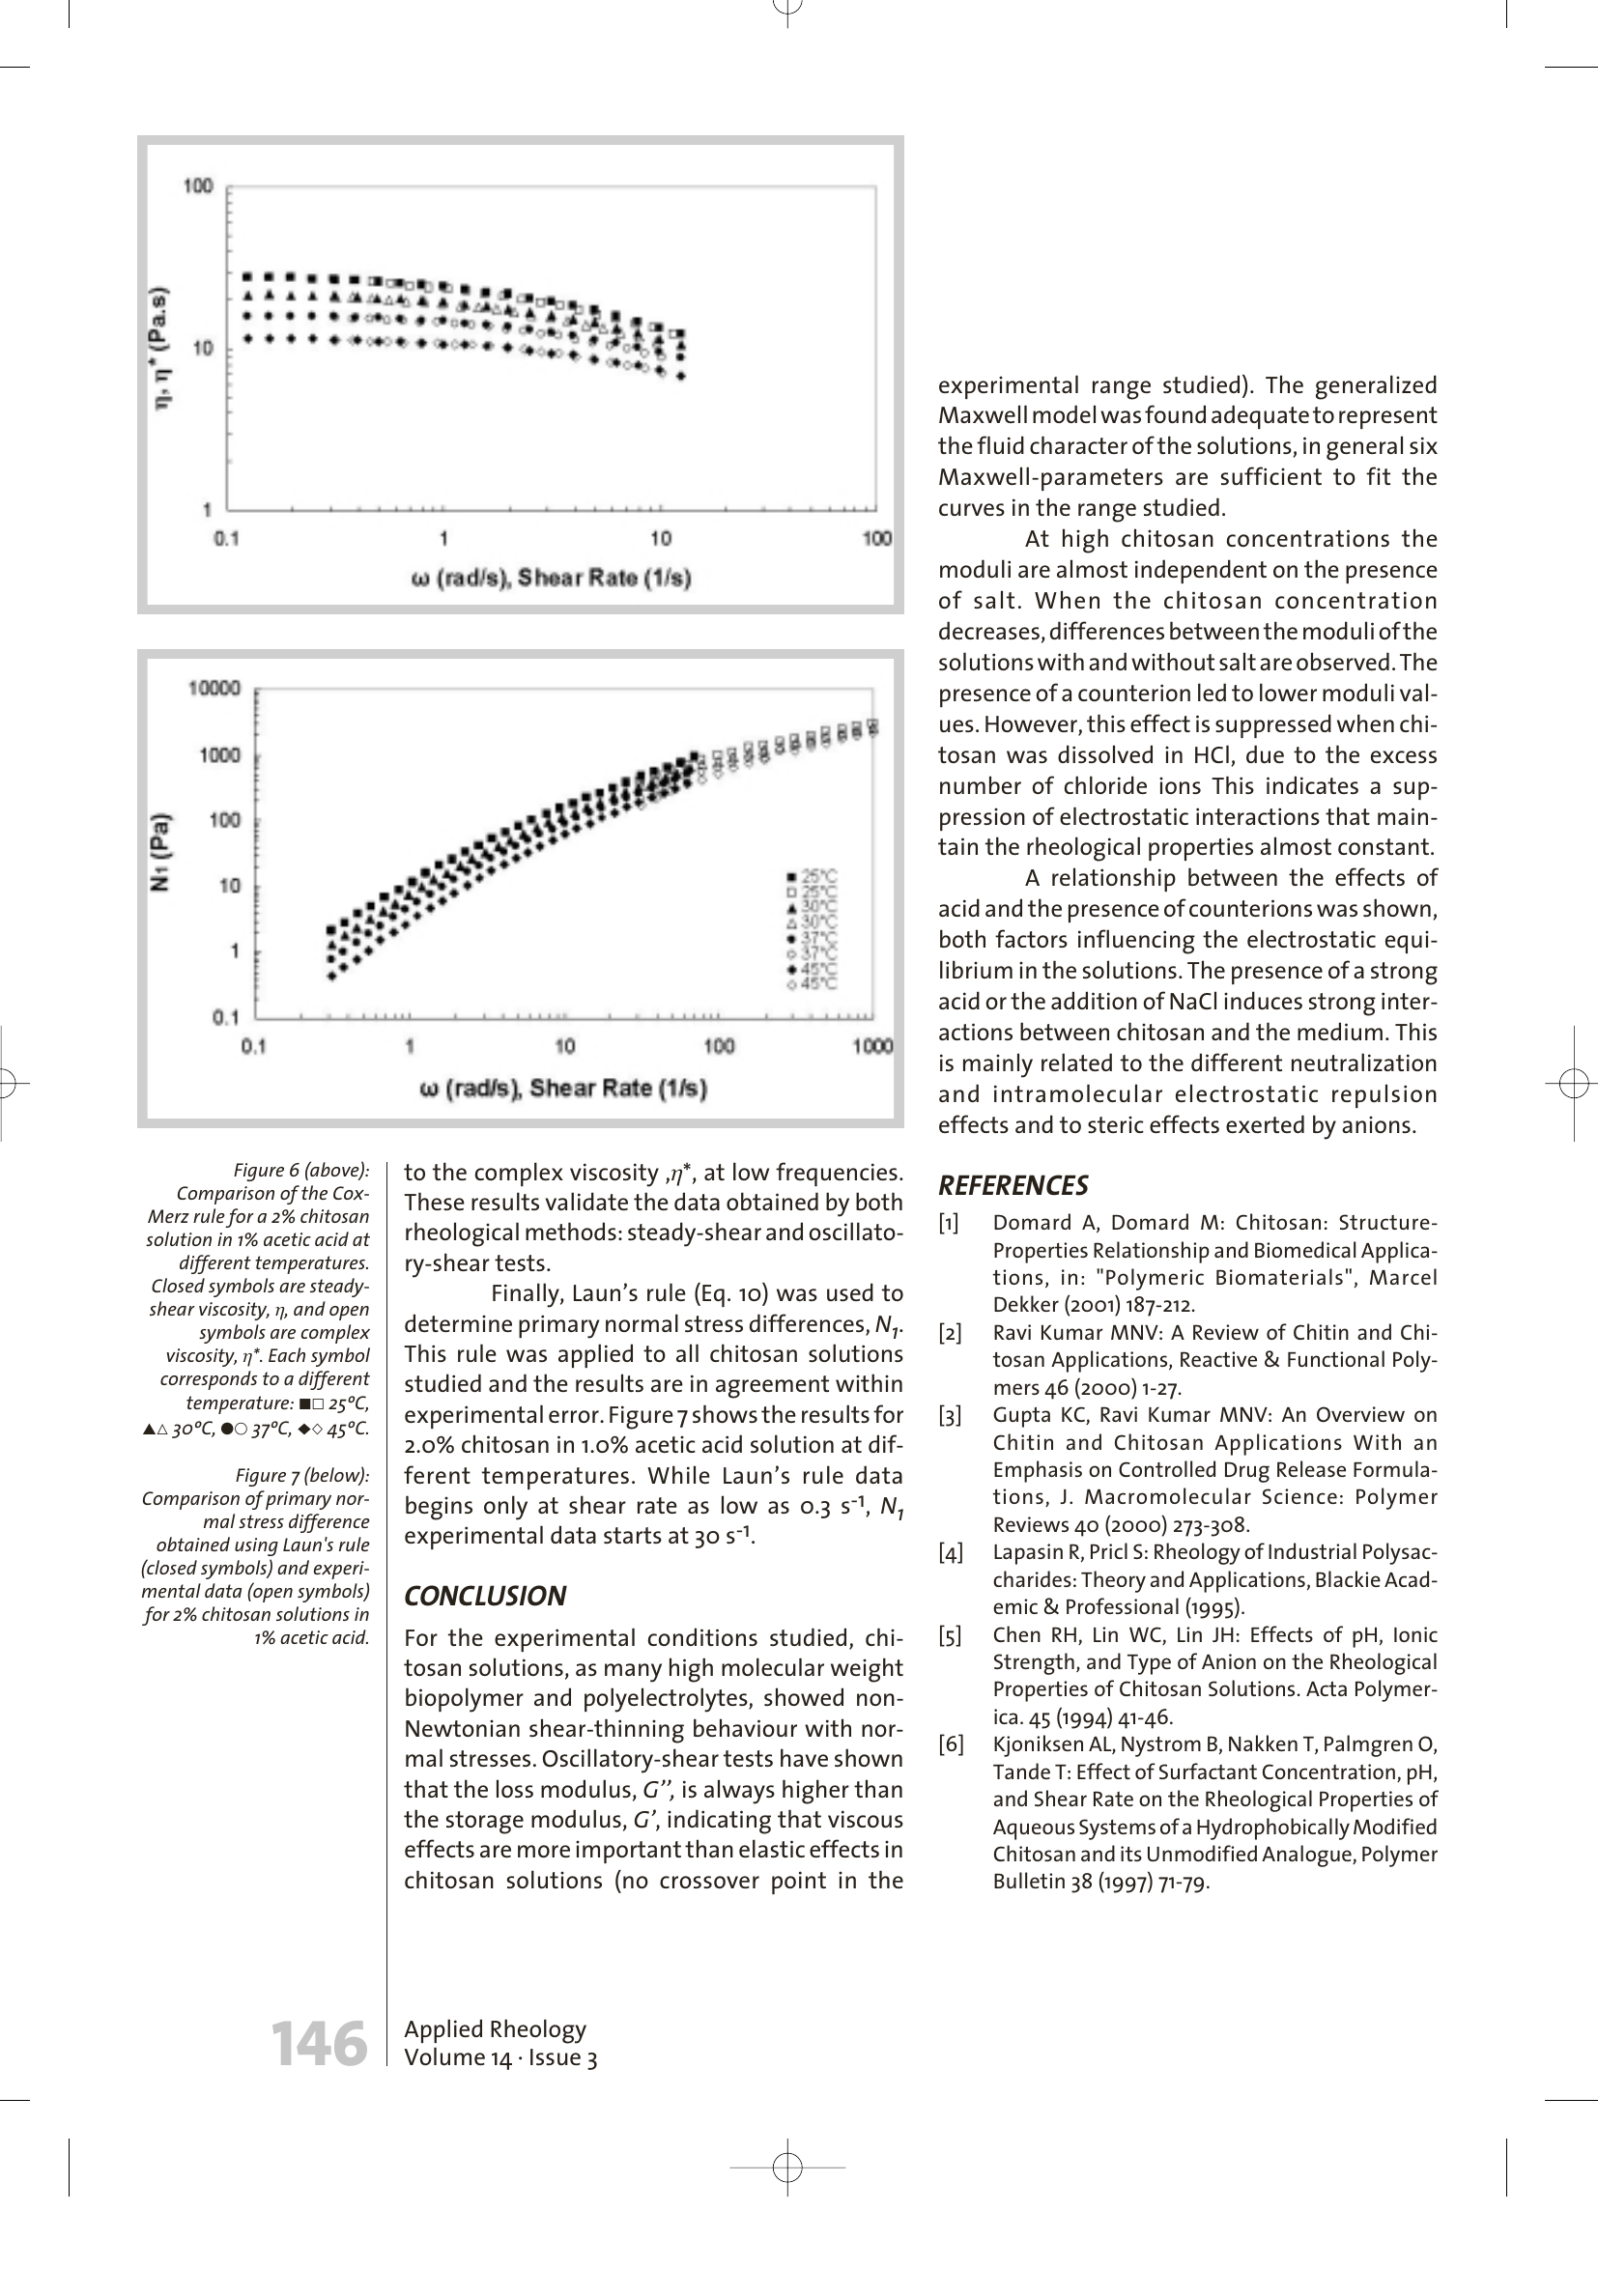
Figure 6 (above): Comparison of the Cox- Merz rule for a 2% chitosan solution in 1% acetic acid at different temperatures. Closed symbols are steady- shear viscosity, h , and open symbols are complex viscosity, h *. Each symbol corresponds to a different temperature: ‡· 25ºC, (cid:3) Û 30ºC, (cid:4) Á 37ºC, ÏÌ 45ºC. Figure 7 (below): Comparison of primary nor- mal stress difference obtained using Laun's rule (closed symbols) and experi- mental data (open symbols) for 2% chitosan solutions in 1% acetic